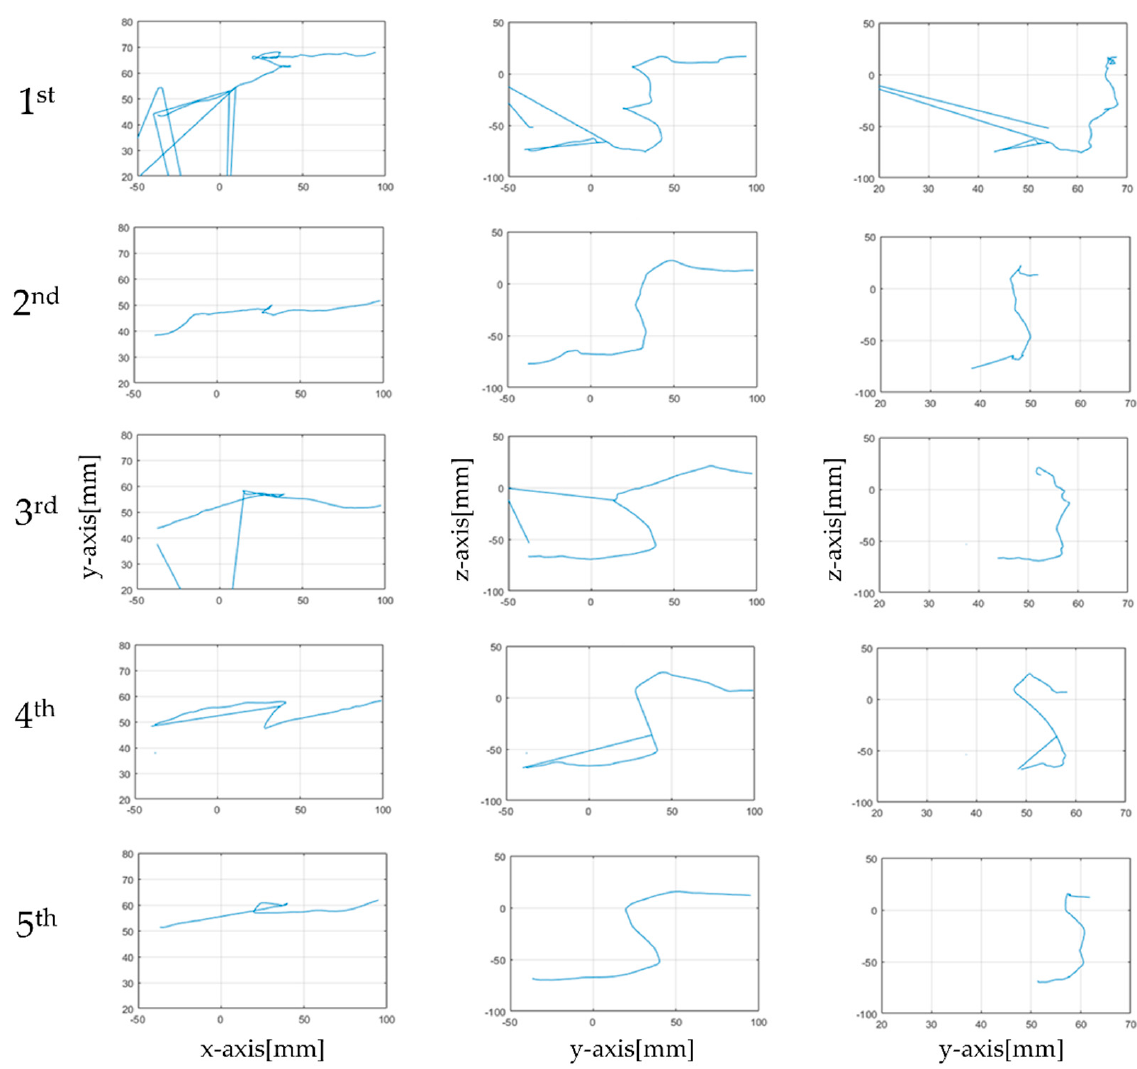
Figure 6. These graphs are a 2D representations of the paths of movement stored in three dimenScheme.